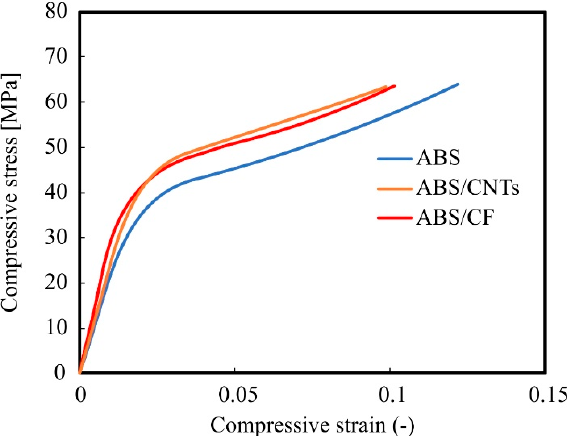
Figure 3. Stress-strain curves of acrylonitrile butadiene styrene (ABS), ABS/carbon nanotube (CNT) and ABS/carbon fiber (CF) specimens.